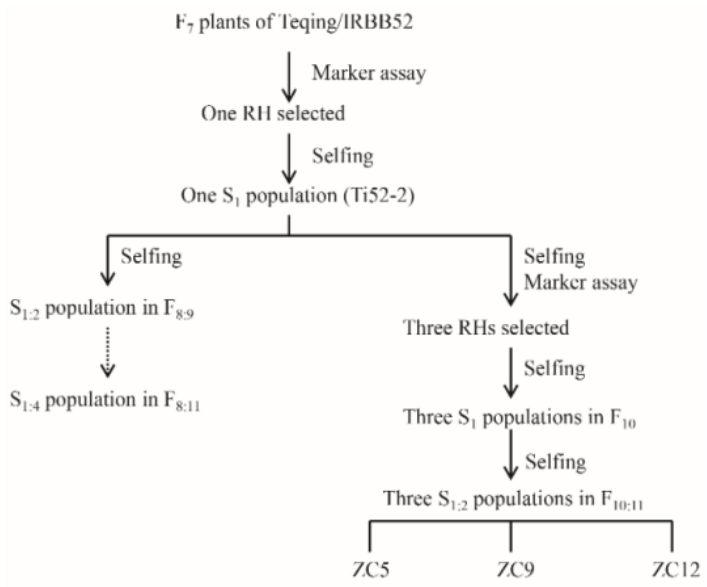
Figure 1. Construction of the rice populations used in this study. RH, residual heterozygote.